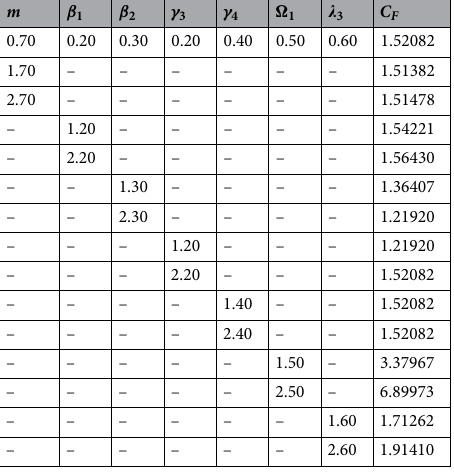
Table 2. Numerical values of skin friction coefficient.